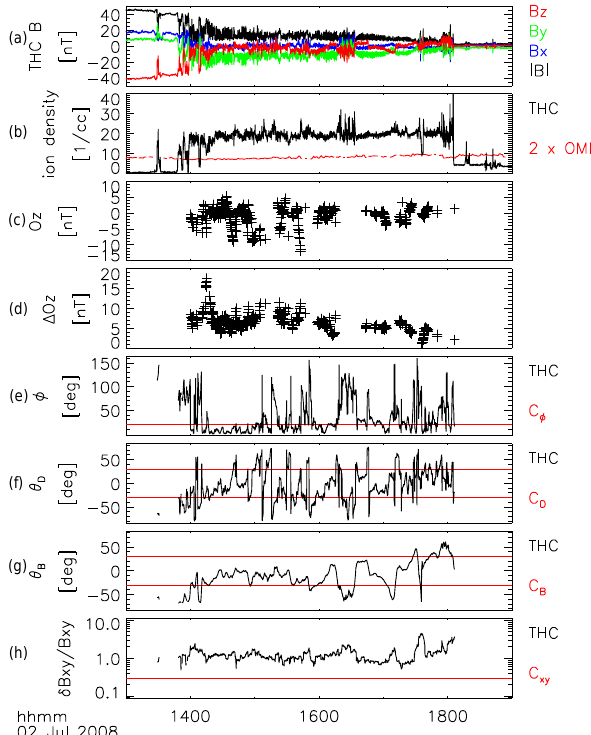
Figure 2. Example interval of THC data of 2 July 2008. Panels from top to bottom: (a) THC FGM magnetic field components in DSL coordinates, (b) THC ESA ion density and twice the OMNI ion density (red line), (c) O z , (d) (cid:49)O z , (e) φ and C φ in red, (f) θ D and C D in red, (g) θ B and C B in red, and (h) δB xy /B xy and C xy in